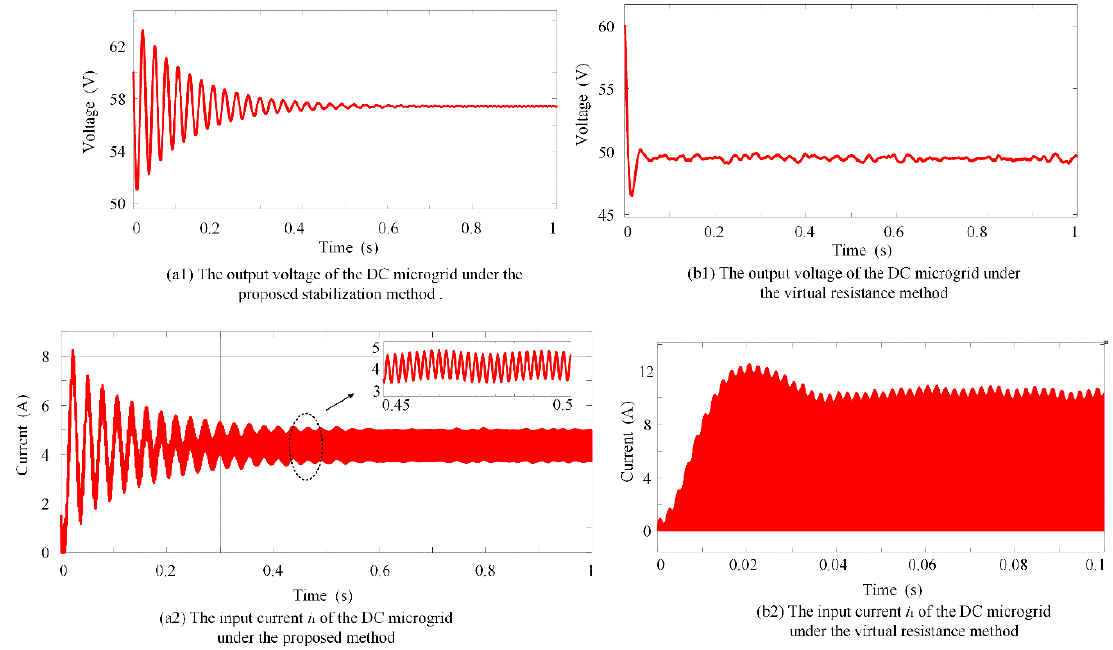
Figure 10. Simulation results.